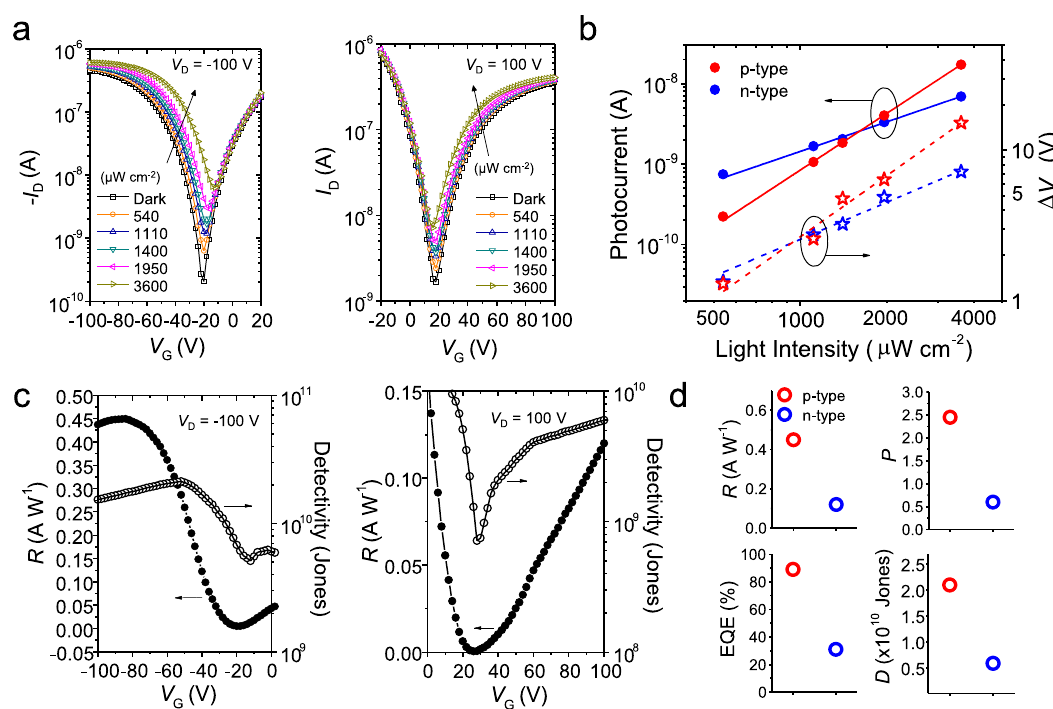
Fig. 5 Optoelectronic performances in the dark and under NIR light irradiations. a Transfer curves of 3a- P -based OFETs in the dark and under light irradiations ( λ = 730 nm) in p -type (left) and n -type (right) modes. b Quantitative analysis results of the photocurrent and V T change of 3a- P -based OFETs under the NIR light irradiations. c R and D* of 3a- P -based OFETs under the NIR light irradiations in p -type (left) and n -type (right) modes. d Maximum R , P , EQE, and D* values of 3a- P -based OFETs under the NIR light irradiations ( λ = 730 nm, 540 μ W cm − 2